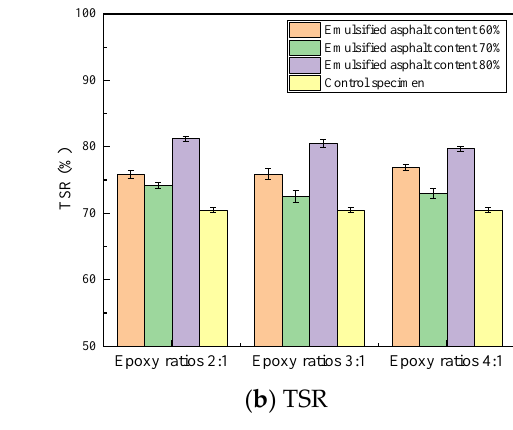
Figure 9. MS 0 and TSR of specimens.